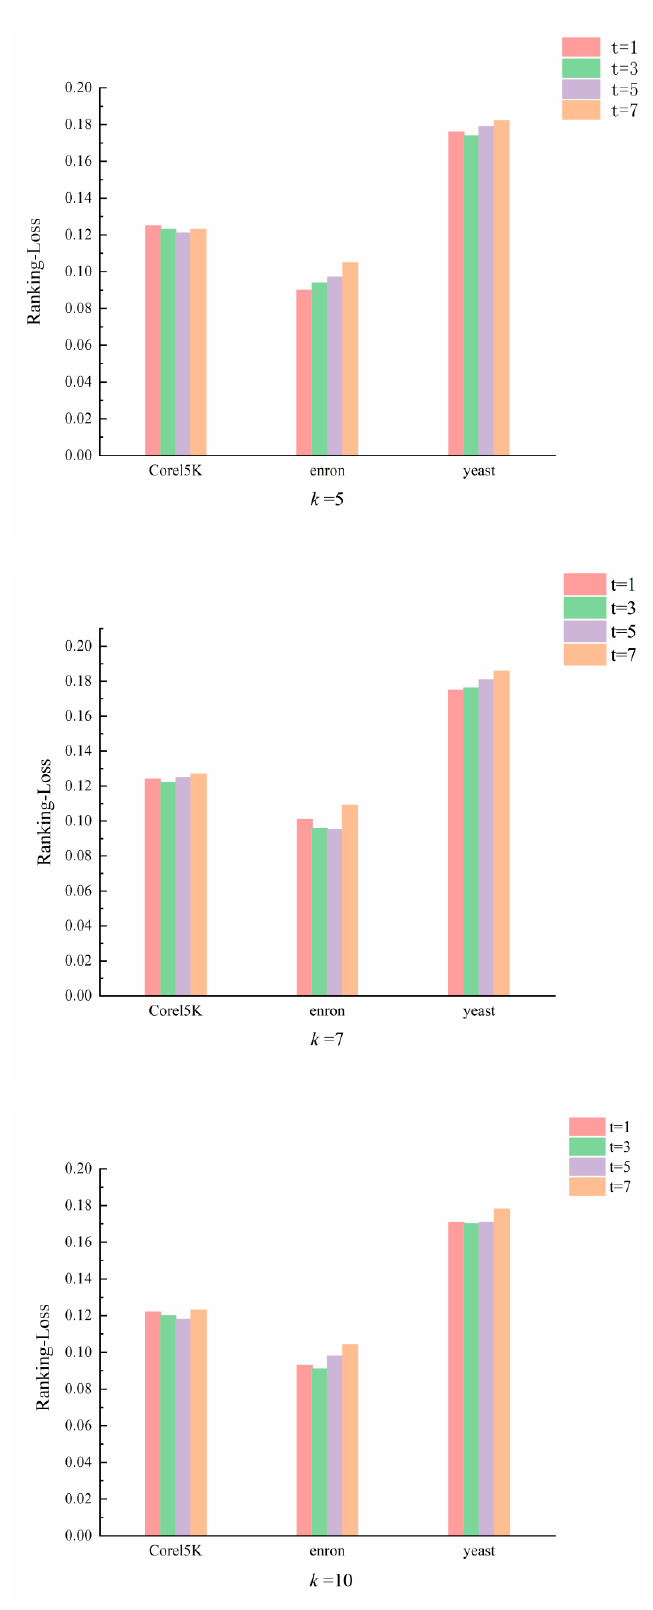
Figure 3. Ranking loss for different values of k and t in different datasets. Different colors represent different values of t .